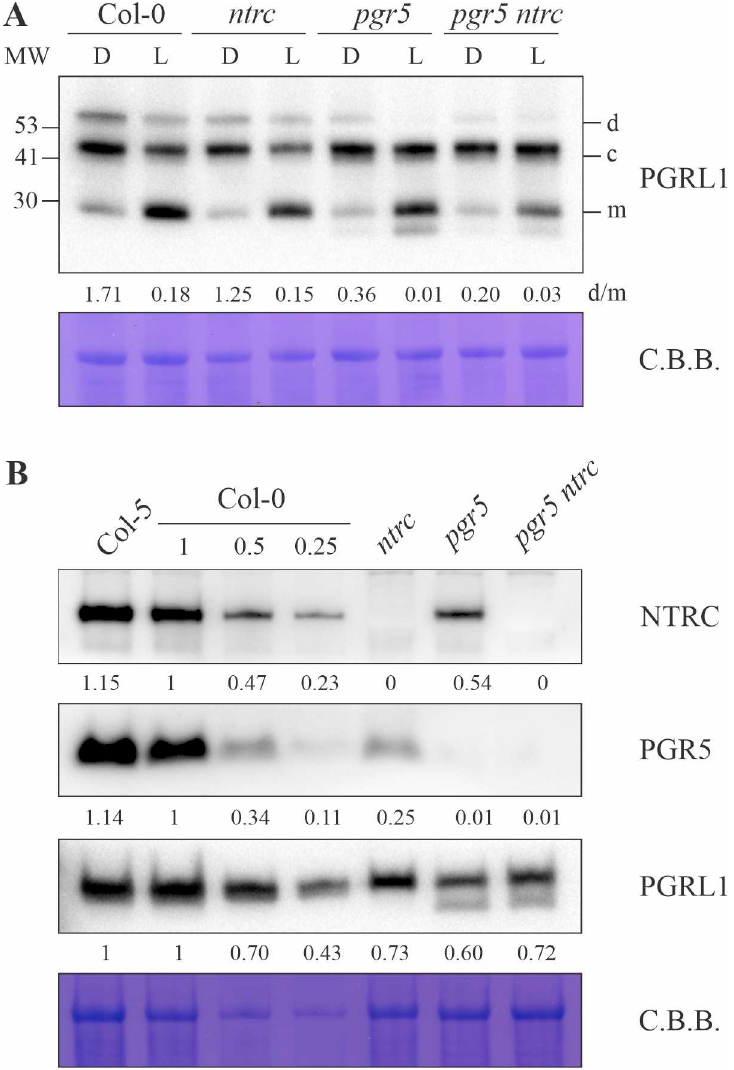
Figure 4. PGRL1 dimer formation and protein accumulation in the absence of NTRC and PGR5. ( A ) Total leaf proteins were obtained from Col-0, ntrc , pgr5 and pgr5 ntrc after 6 weeks of growth under short-day conditions, precipitated with TCA and alkylated using NEM at the end of the dark period (dark, D) and after a 30-s exposure to light (L, 100 µmol photons m − 2 s − 1 ). Samples were fractionated by SDS-PAGE and subjected to immunoblotting using PGRL1-specific antibody. MW stands for molecular weight scale (KDa). d, c and m indicate dimer, complex and monomer forms of PGRL1, respectively. A representative blot from three experiments is presented, and the ratio of PGRL1 dimers to monomers (d/m), based on the quantification of band intensities, is shown below the panel. ( B ) Aliquots of total leaf proteins from Arabidopsis wild type (Col-5 and Col-0), ntrc and pgr5 single mutants and pgr5 ntrc double mutant after 6 weeks of growth under short-day conditions were fractionated by SDS-PAGE and subjected to immunoblotting using NTRC-, PGR5- or PGRL1-specific antibodies. Decreasing amounts of Col-0 were loaded. Representative blots from three experiments are presented, as well as the values corresponding to the quantification of the intensity of each band relative to Col-0 100%. In both ( A ) and ( B ), protein samples were adjusted according to fresh weight, and PVDF membranes were stained with Coomassie brilliant blue (C.B.B.) to show protein loading.